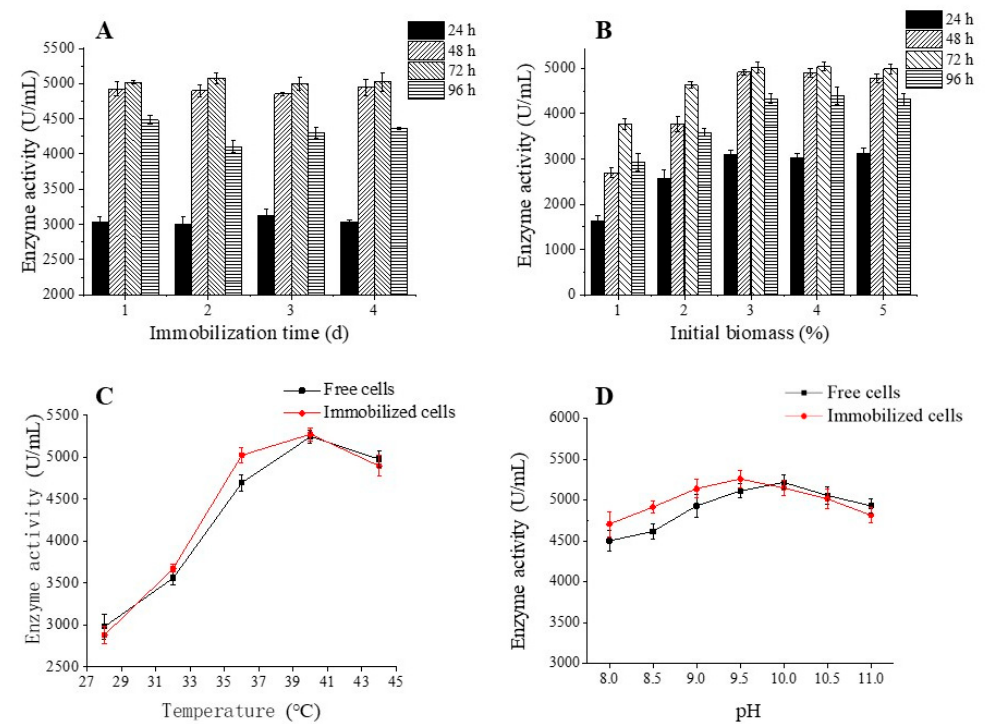
Figure 3. Effect of immobilization time ( A ), initial biomass ( B ), temperature ( C ), and pH ( D ) on the production of palm curtain immobilized Bacillus circulans ATCC 21783 enzyme activity.